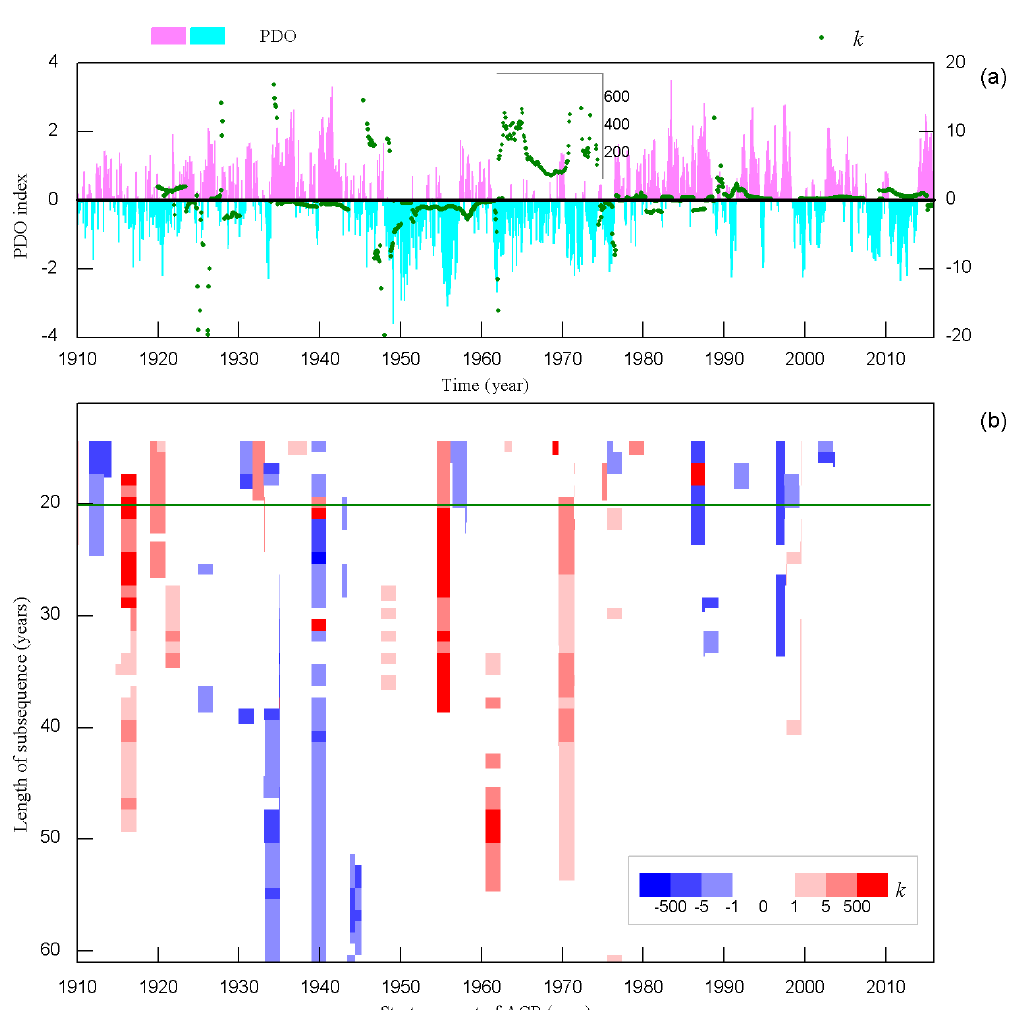
Figure 6. Identification of the PDO time sequence and instability parameter k with different subsequence lengths. (a) The histogram rep- resents the PDO time sequence (left y axis), and the green dots indicate the value of parameter k when the subsequence is 20 years (right y axis), where the x axis represents time in year. (b) The start moments of transition processes with different subsequence lengths (the red dots represent increasing processes, and blue dots represent decreasing changes, with deeper colors representing higher values). The green line shows that the value of the subsequence is 20 years. The x axis represents the start moment of abrupt change in year, and the y axis represents the subsequence length in